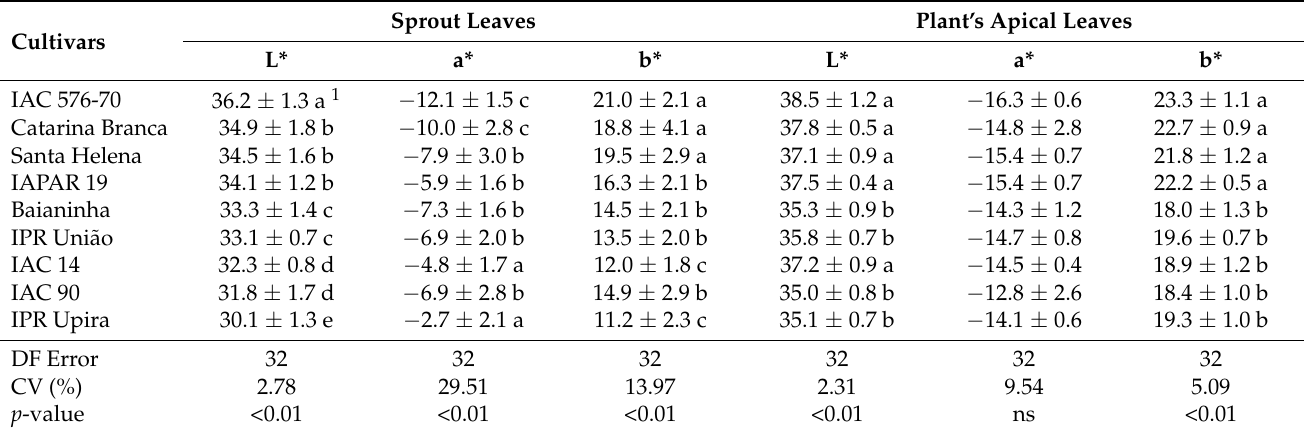
Table 3. Median values ( ± standard deviation) from the Luminosity (L*) and Chroma (a* and b*) parameters in sprout leaves and plant’s apical leaves, from nine cassava cultivars. Londrina. Paran á .